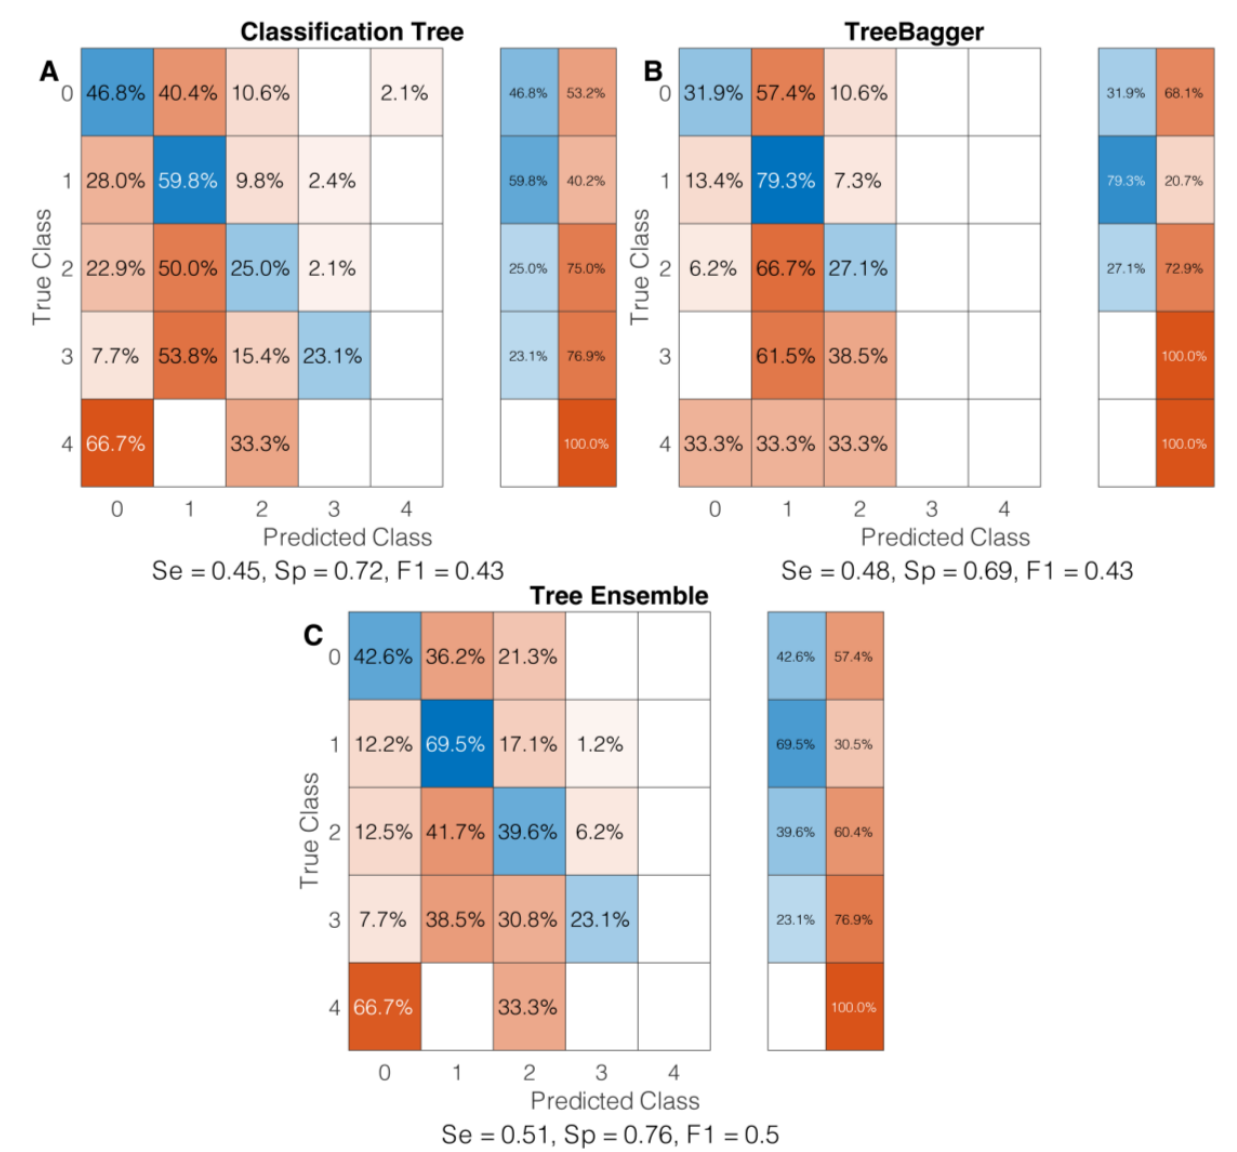
Figure 3. Confusion charts of three learners: classification tree ( A ), Treebagger ( B ), tree ensemble ( C ). Se = sensitivity, Sp = specificity, F1 = F score. All the models in this figure were cross-validated with 5-fold cross-validation.